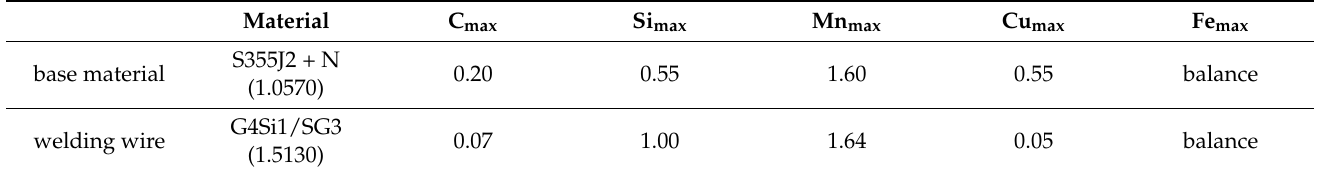
Table 1. Chemical composition of substrate [46] and welding wire [47]